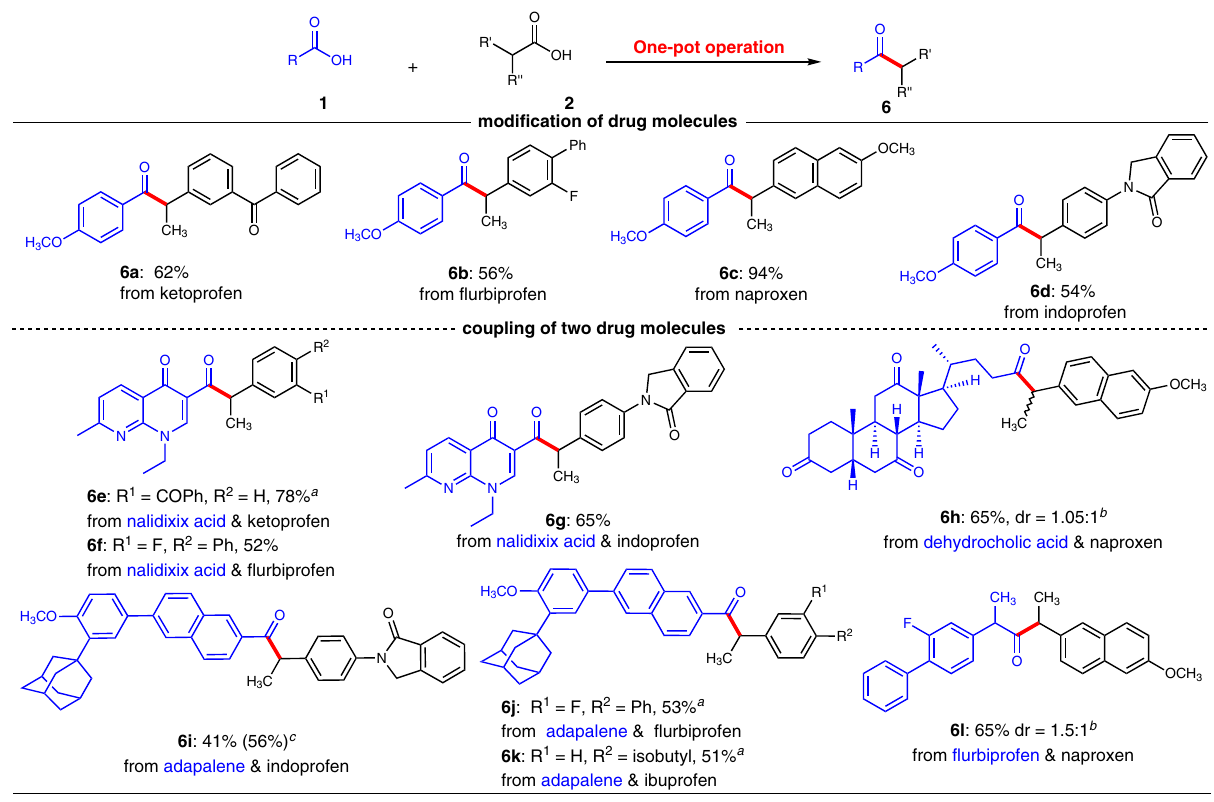
Fig. 5 Application of the method in modi fi cation of drug molecules. Reaction conditions: 1 (1.5 equiv), 2 (0.05-0.1 mmol, 1.0 equiv), B (20 mol%), PC-3 (1 mol %) and Cs 2 CO 3 (2.0 equiv) in MeCN, blue LED (Kessil PR160 series, λ max = 427 nm), Ar atmosphere, 30 – 40 °C, 24 h. a Pre-prepared acyl imidazoles were used. b Blue LEDs (Kessil PR160 series, λ max = 440 nm) were used. c Yield in parentheses is obtained by using pre-prepared acyl imidazole as starting